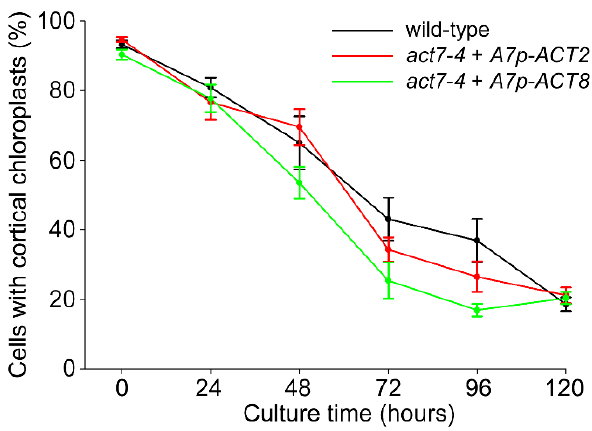
Figure 6. Over ‐ expression of the vegetative actins ACT2 and ACT8 suppresses the act7 ‐ 4 phenotype. Chloroplast clustering is indistinguishable between wild ‐ type or two transgenic lines whereby ACT2 and ACT8 are expressed in the act7 ‐ 4 mutant under control of the ACT7 promoter. Data is mean ± SE, n = 3 experiments.